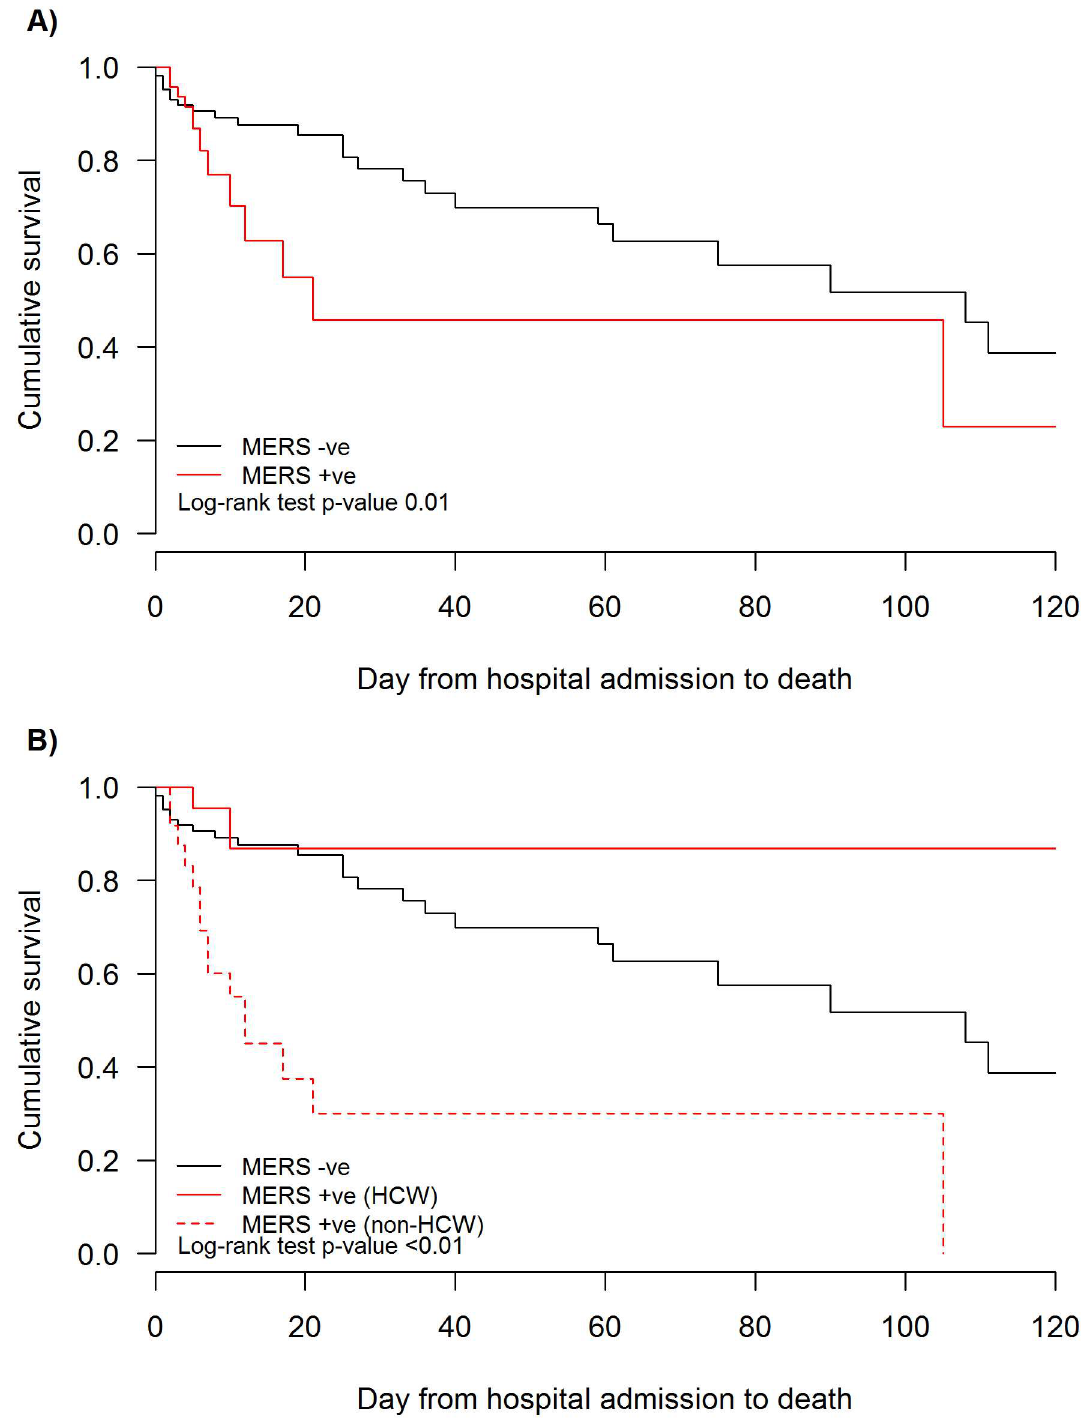
Fig 1. Time from hospital admission to death. A: Comparingpatients with MERS-CoV infection (red line) and those negative for MERS-CoV (black line) (p = 0.01). B: Comparinghealth care workers with MERS CoV (red dotted line; group1), non-HCW with MERS (red solid line; group 2) and patients without MERS-CoV infection (black solid line; group 3). Log rank test group 1 vs. group 2 p = 0.003; group 2 vs group 3 p = 0.45; group 1 vs group 3 p < 0.001.